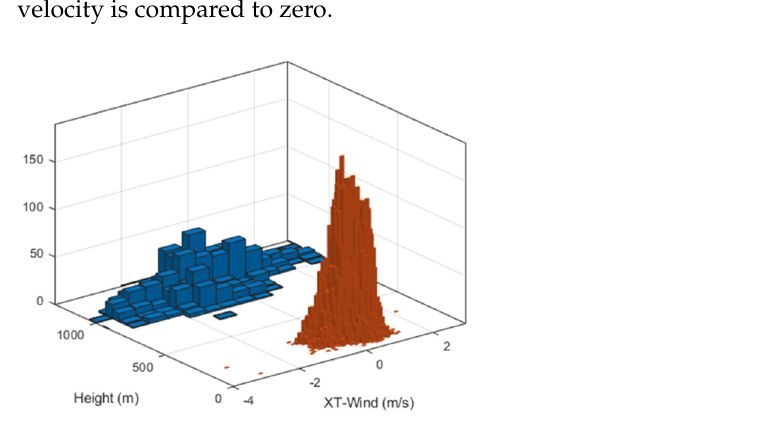
Figure 10. Histogram of retrieved XT wind and height shows low clouds with small XT velocities and a larger population of clear-sky ground retrievals.